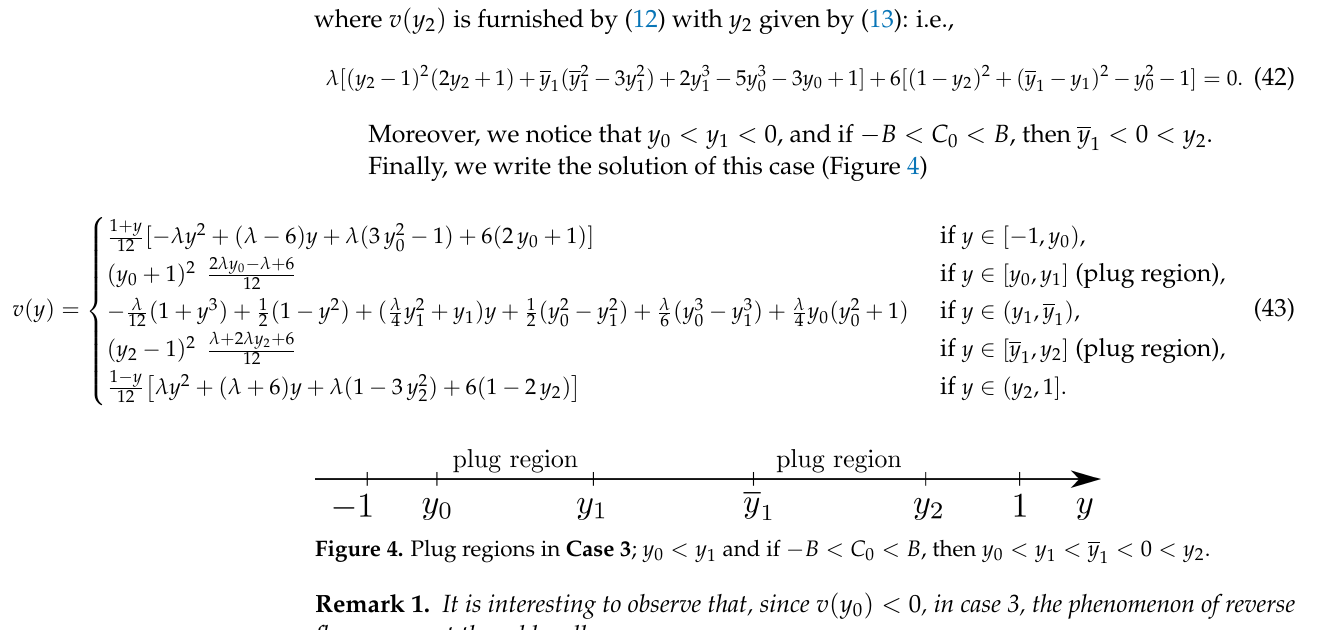
Figure 4. Plug regions in Case 3 ; y 0 < y 1 and if − B < C 0 < B , then y 0 < y 1 < y